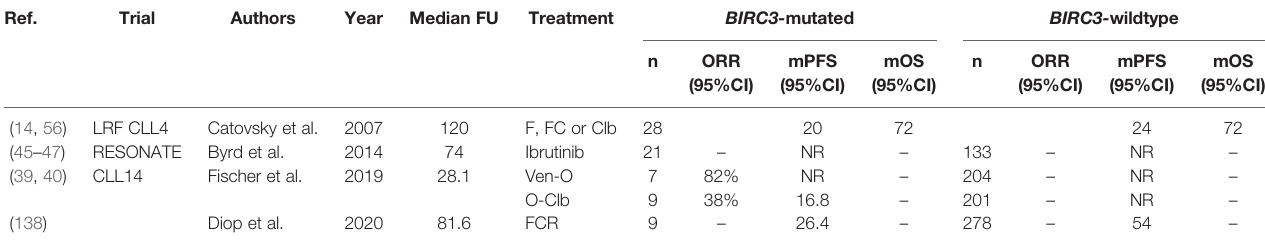
TABLE 9 | An overview of clinical trials comparing treatment regimens in patients with BIRC3 mutated CLL. Ref.